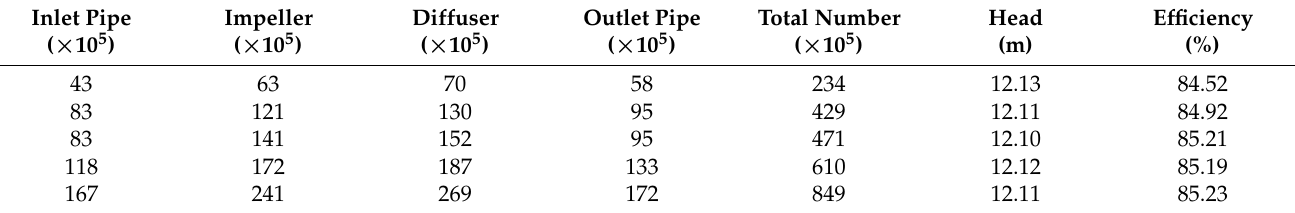
Table 1. Mesh independence